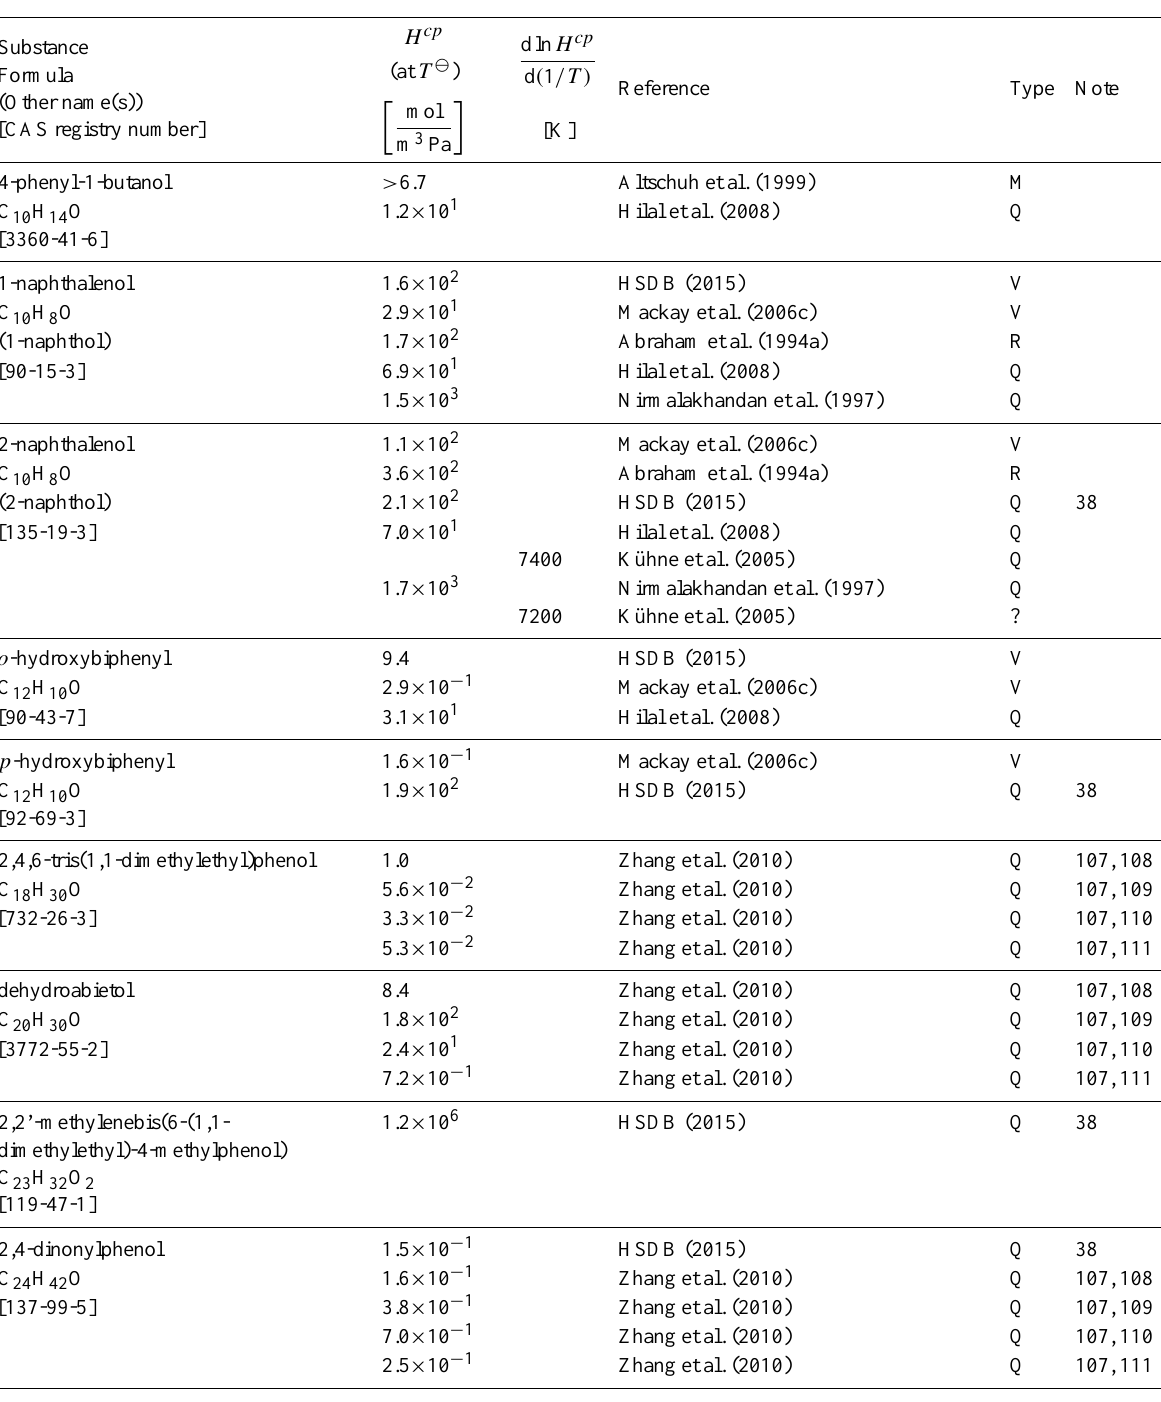
Table 6: Henry’s law constants for water as solvent